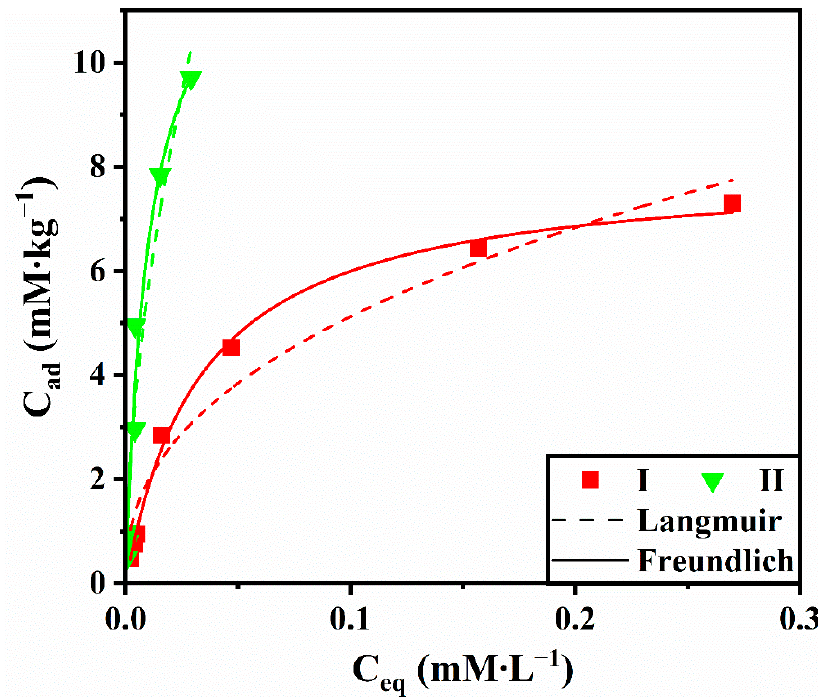
Figure 3. Adsorption isotherms of Cu(II) by soil in pure form (I) and soil with rice husk biochar (II). Table 3. Fitted parameters for adsorption isotherms of Cu(II) by soil in pure form and with rice husk biochar.